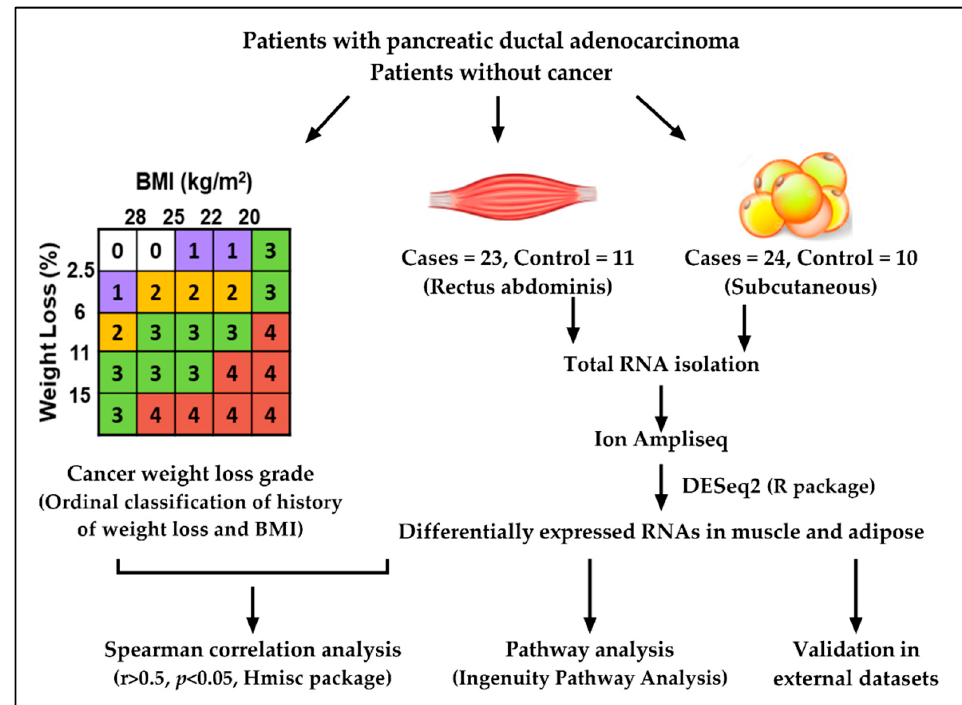
Figure 1. Overall study design.